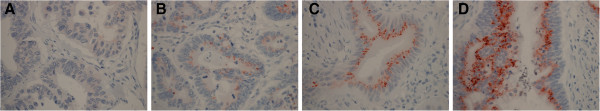
Immunohistochemical scoring pattern of MMP-9 in colorectal cancer.A no expression, B mild, C moderate, D strong.